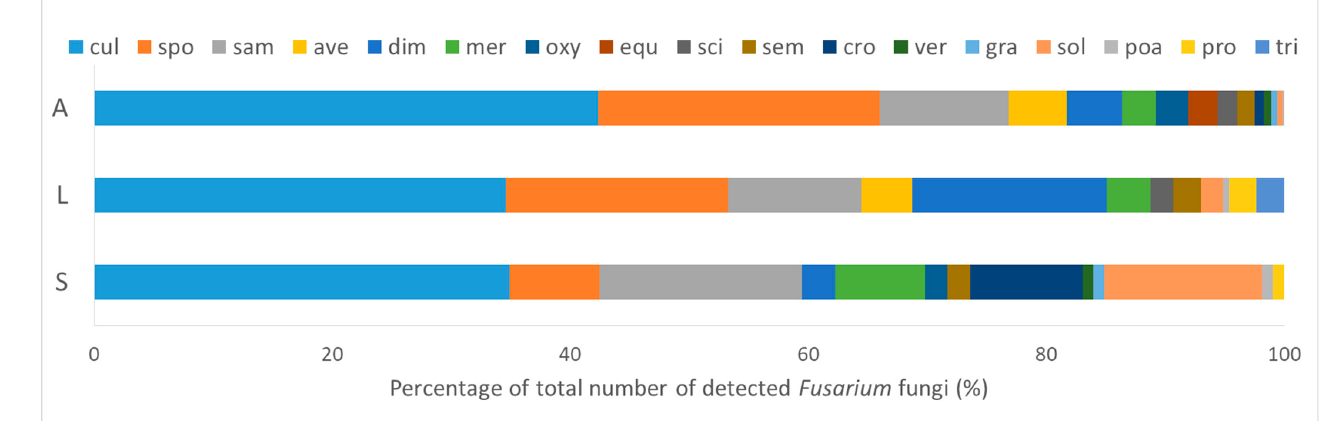
Figure 5. Dominance structure as percentage of each Fusarium ( F. ) species of the total number of detected Fusarium colony forming units (CFU), isolated from the body surface of ground-dwelling arthropods (A, CFU indiv − 1 ), litter (L), and soil (S) (CFU g − 1 DM). Species code: F. culmorum (cul), F. sporotrichioides (spo), F. sambucinum (sam), F. avenaceum (ave), F. dimerum (dim), F. merismoides (mer), F. oxysporum (oxy), F. equiseti (equ), F. scirpi (sci), F. semitectum (sem), F. crookwellense (cro), F. verticillioides